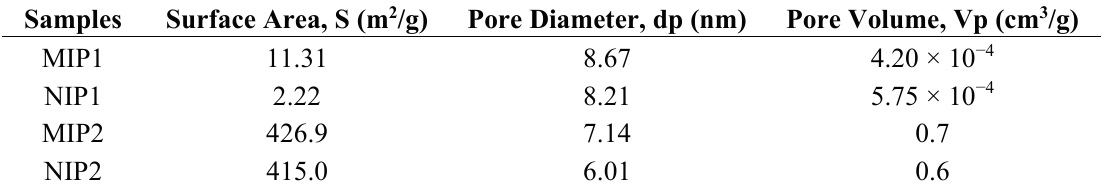
Table 1. Brunauer-Emmett-Teller (BET)